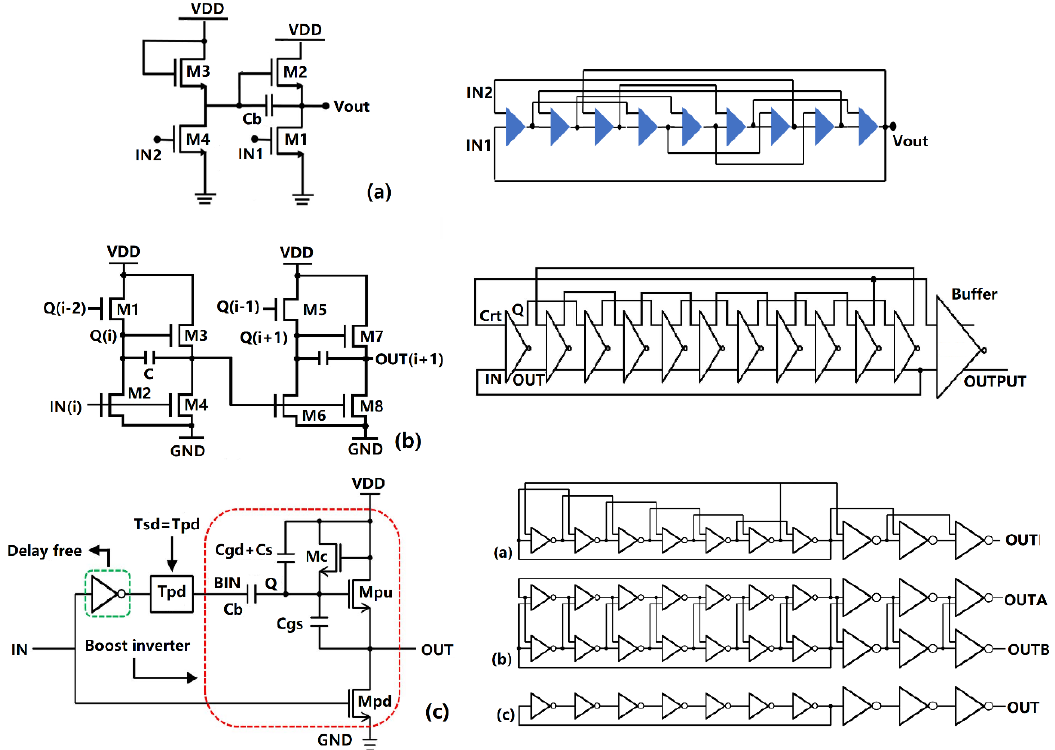
Figure 13. Oscillator with an optimized pseudo-CMOS inverter: ( a ) Diode-connected oscillator, ( b ) Pull-up control oscillator [79], and ( c ) Skewed delay oscillator [85].